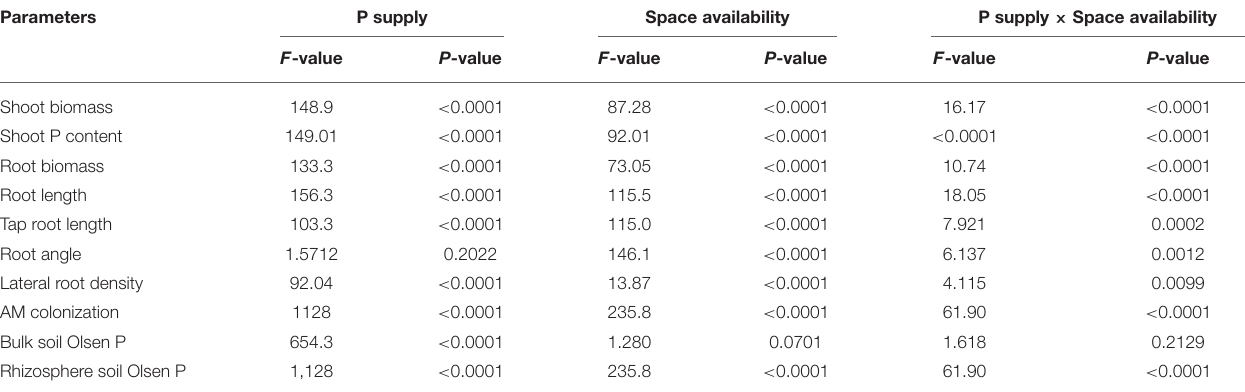
TABLE 1 | Two-way ANOVA of the effects of phosphorous (P) supply, space availability, and their interaction on P supply and space availability. Parameters P supply Space